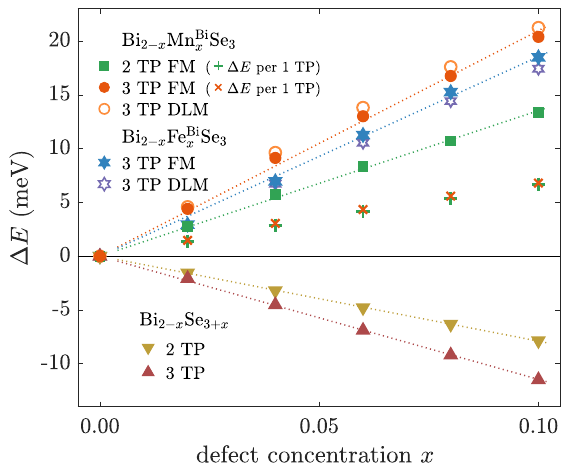
Figure 6. Relative change of the TP formation energy ∆ E as a function of the concentration of defects x . Structures either with two ( T 7 20 QLs were used. Dependencies under presence of magnetic and native defects are depicted. ( + ) and ( × ) denote hypothetical relative formation energy related to a single TP. Dotted lines depict calculated linear